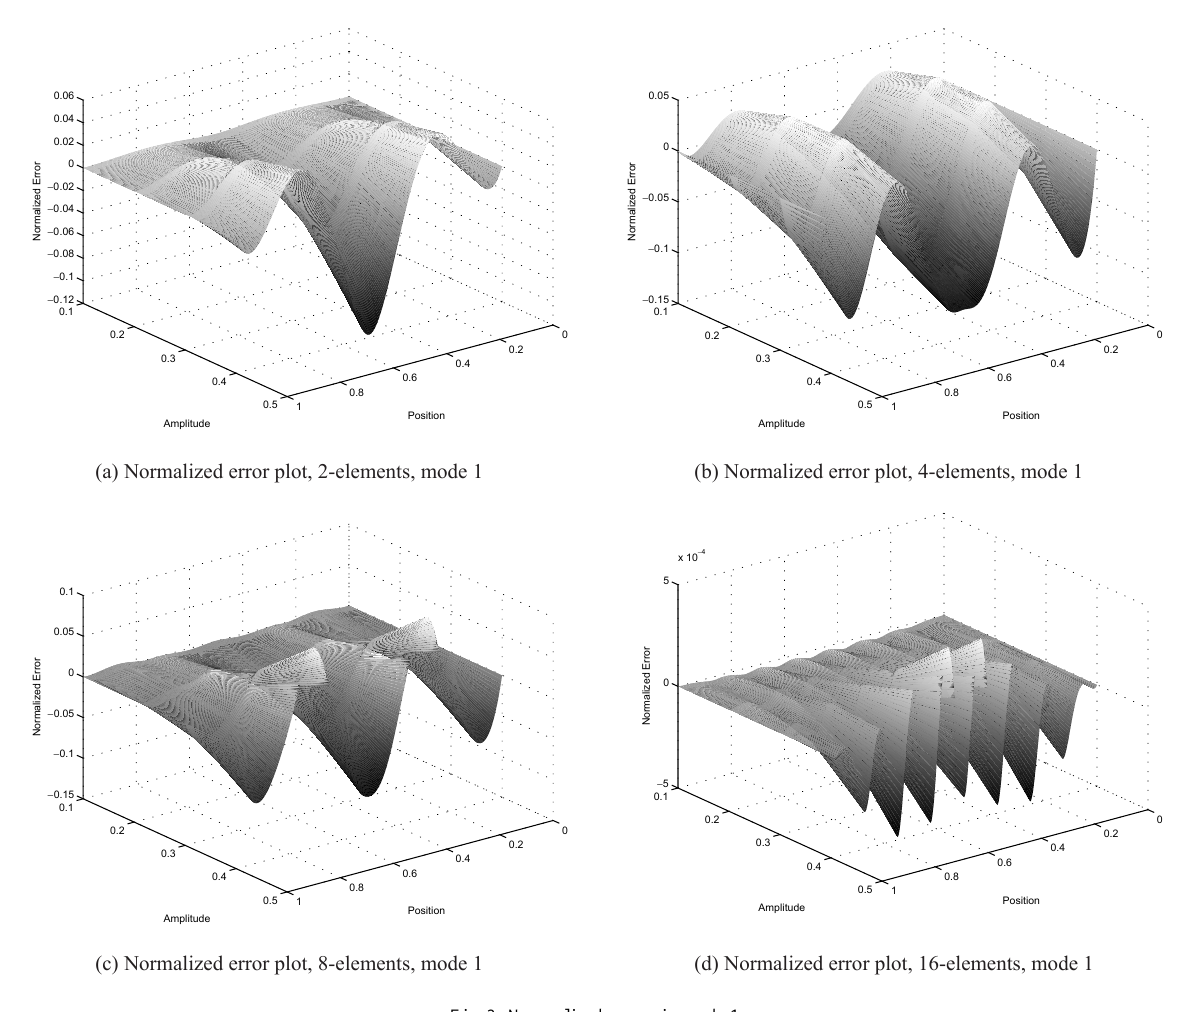
Fig. 3. Normalized errors in mode